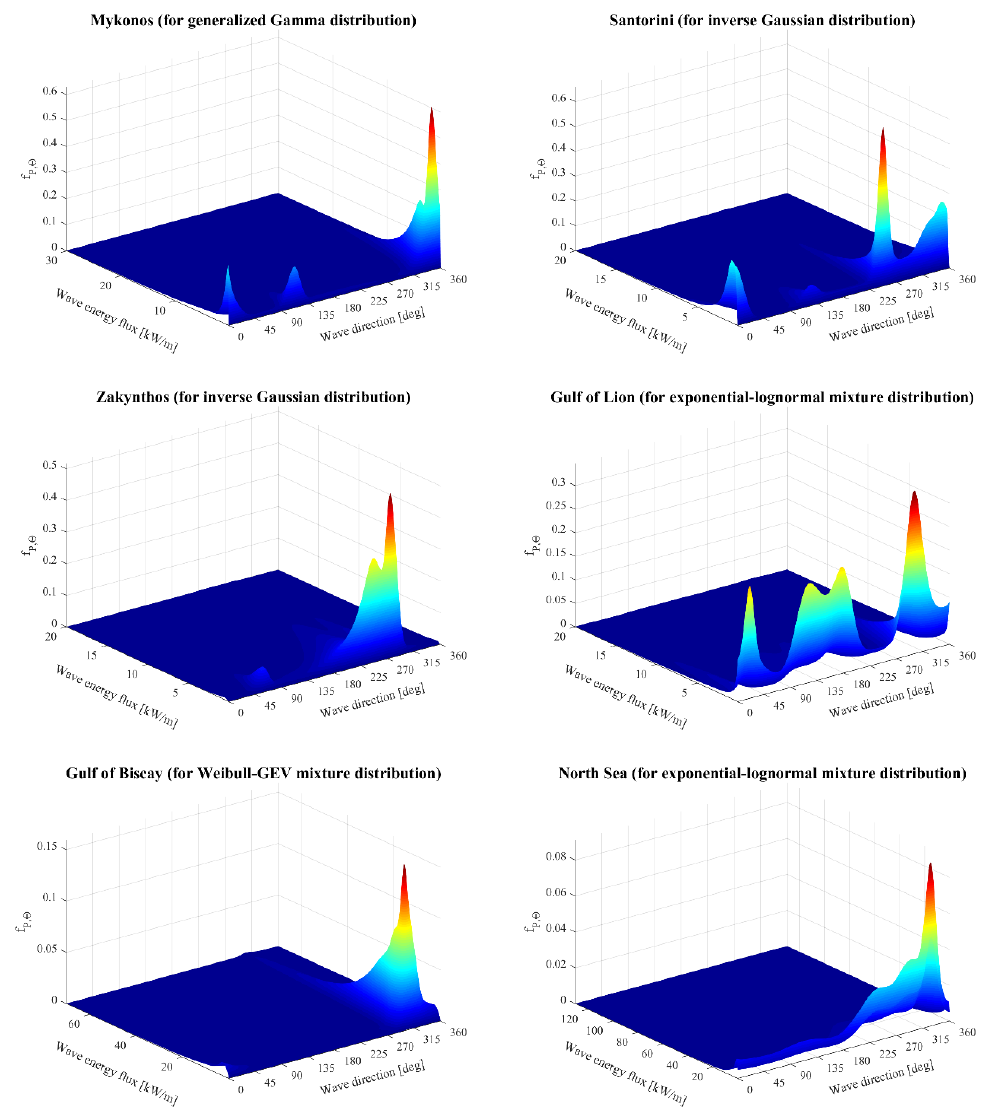
Figure 5. Bivariate best-fit pdfs of wave energy flux and mean wave direction for the examined locations.